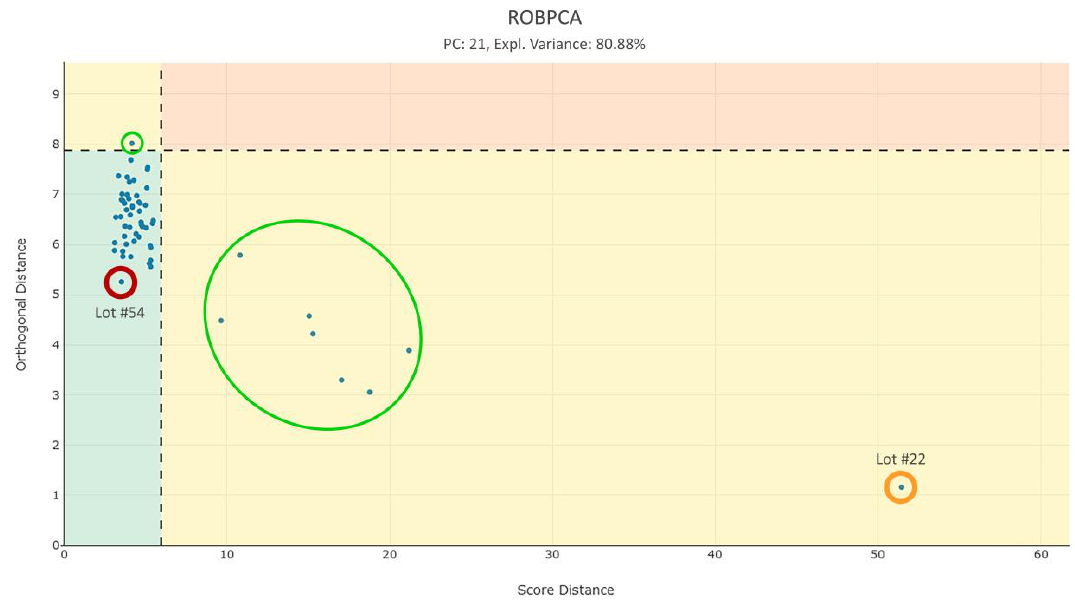
Figure 8. Outlier plot showing all 58 lots (blue points) with their associated scores and orthogonal distance. Additionally, the 97.5% tolerance intervals are indicated as dashed lines, which separate the plot in four differently colored quadrants. Observations in the green quadrant obey the multivariate model, whereas observations in the yellow quadrants indicate orthogonal (upper-left) or score distance (lower-right) outliers. Observations in the yellow quadrants, but close to the 97.5% TI, can be considered as moderate outliers (green circles). The red quadrant includes lots which are suspicious in both directions. Lot #22, shown as encircled in orange, is identified as most prominent outlier within the score distance. Lot #54, shown encircled in red, is closest to the model mean (0,0). No score and orthogonal outlier were observed. The robust principal component analysis (ROBPCA) was built with 21 principal components and explains 80.88% of the variance.